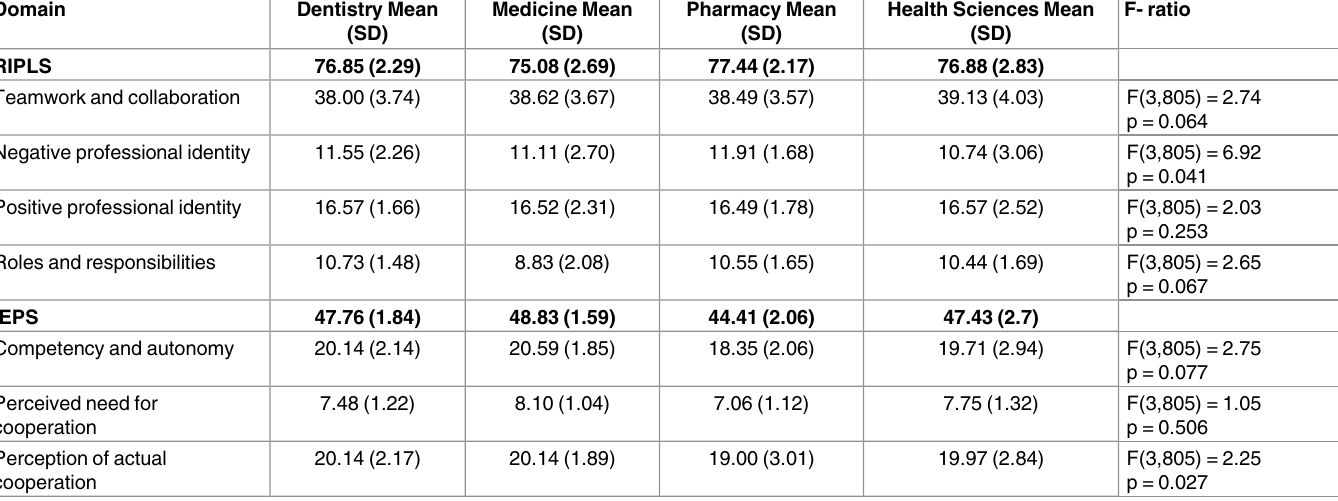
Table 4. RIPLS and IEPS domain scores for each discipline (mean and standard